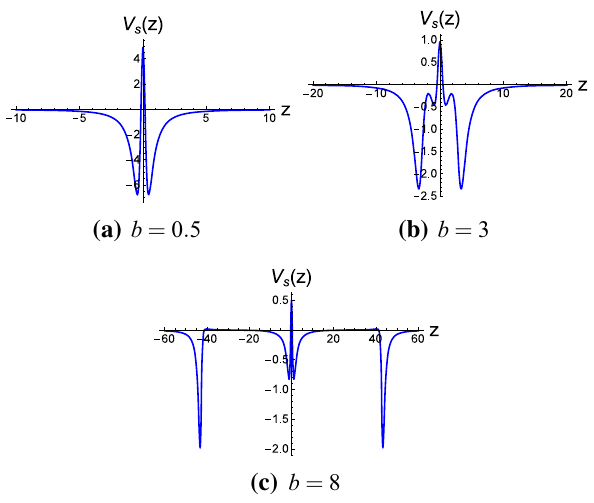
Fig. 7 a b = 0 . 5, b b = 3, c b = 8. The effective potential V s ( z ) for model 2. The parameters are set k = 1, v = 1 and b = 0 . 5 in a , b = 3 in b , b = 8 in c